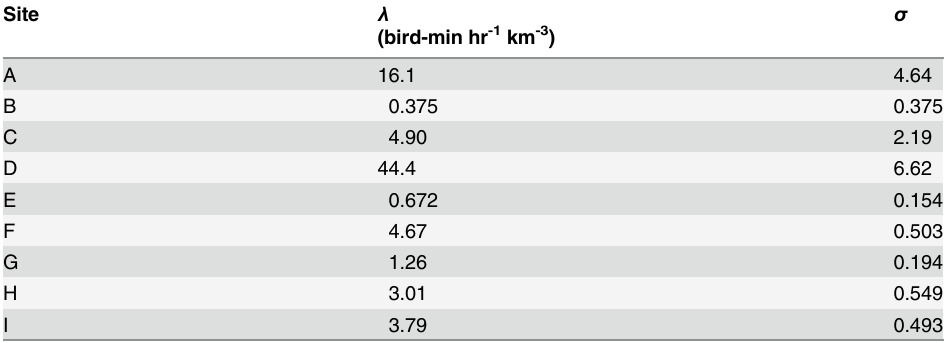
Table 1. The data on golden eagle exposure used to construct the prior for λ (bird-min hr -1 km -3 ). Data on the mean and variance of λ were collected at nine independent sites within the U.S., all with varying levels of exposure. Site names are redacted in order to protect proprietary